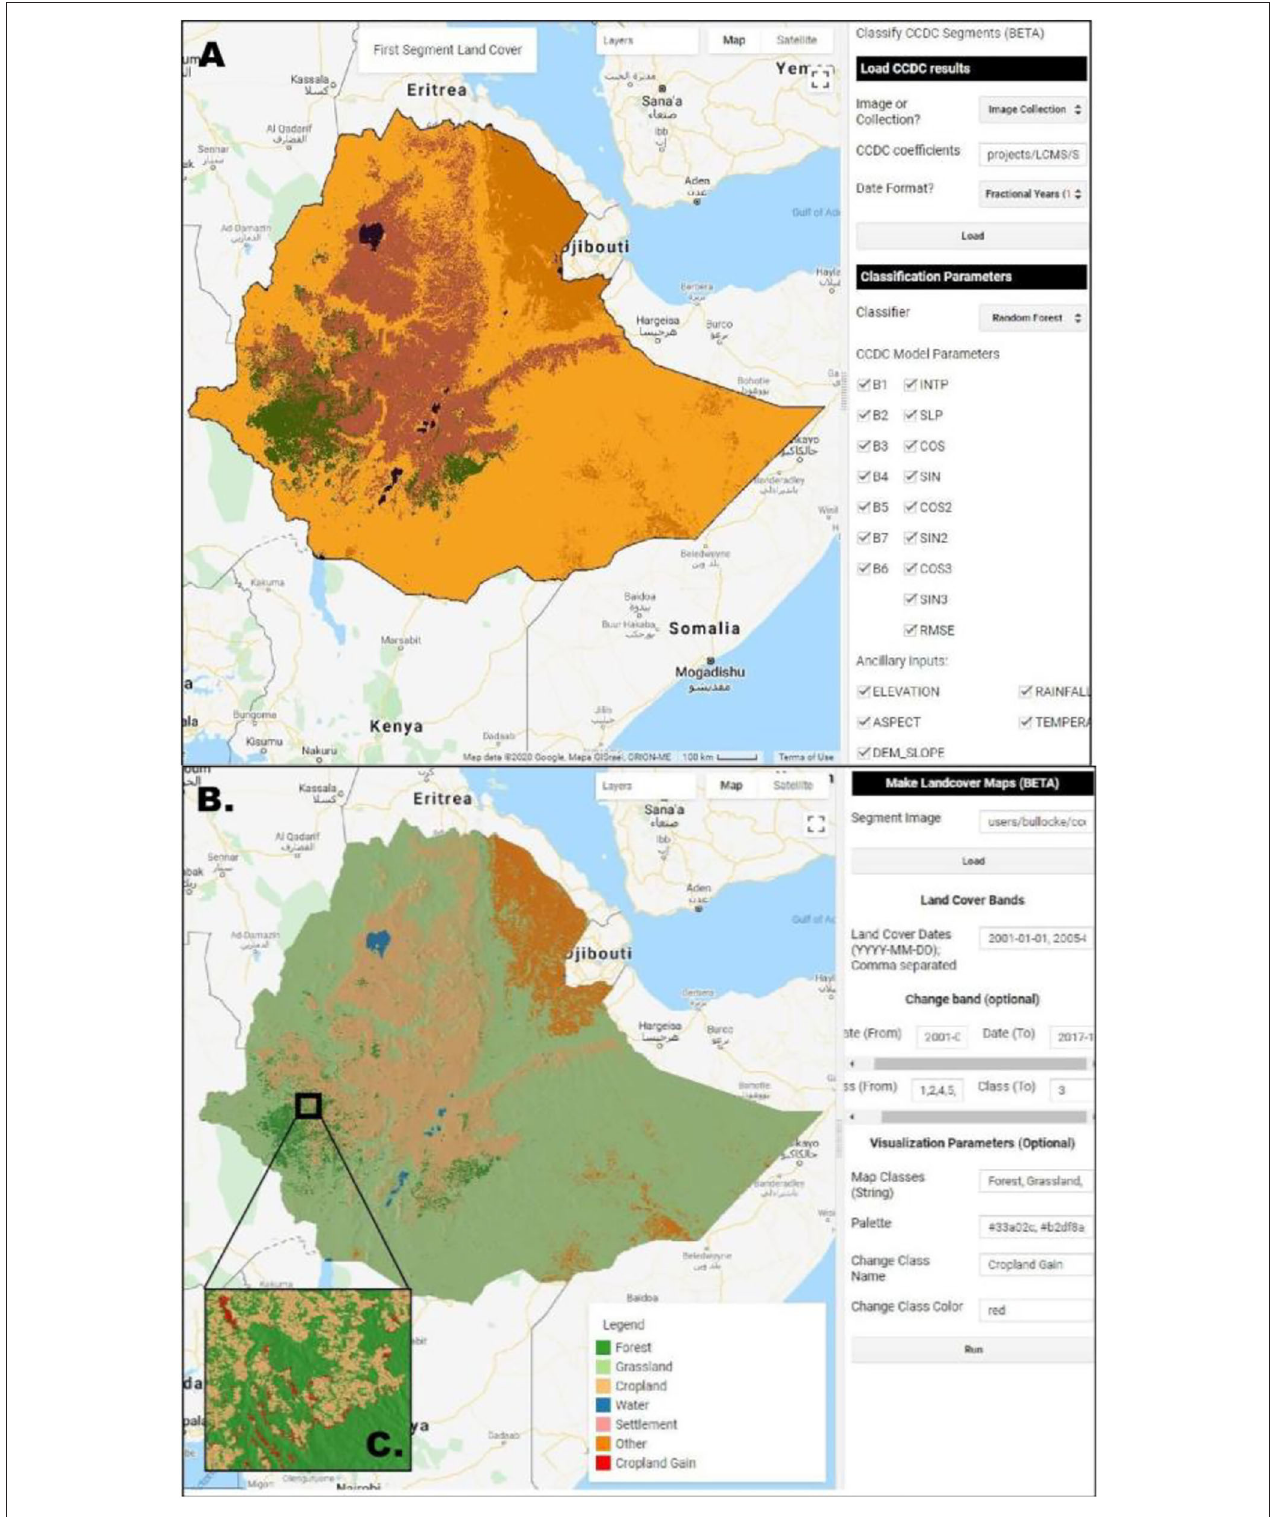
FIGURE 6 | Screenshots of the Classification Tool used to classify CCDC segments for the country of Ethiopia (A) , the Land Cover Tool which allows users to extract categorical maps, including maps of change, for any desired date or dates (B) , and a subset of (B) that shows pixels classified as cropland gain due to displacement of forest (C)